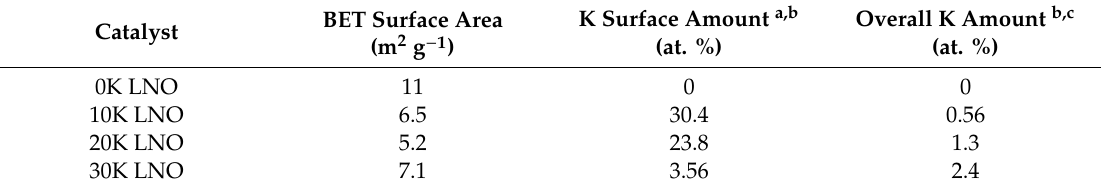
Table 1. Surface parameters of the 0–30K LNO